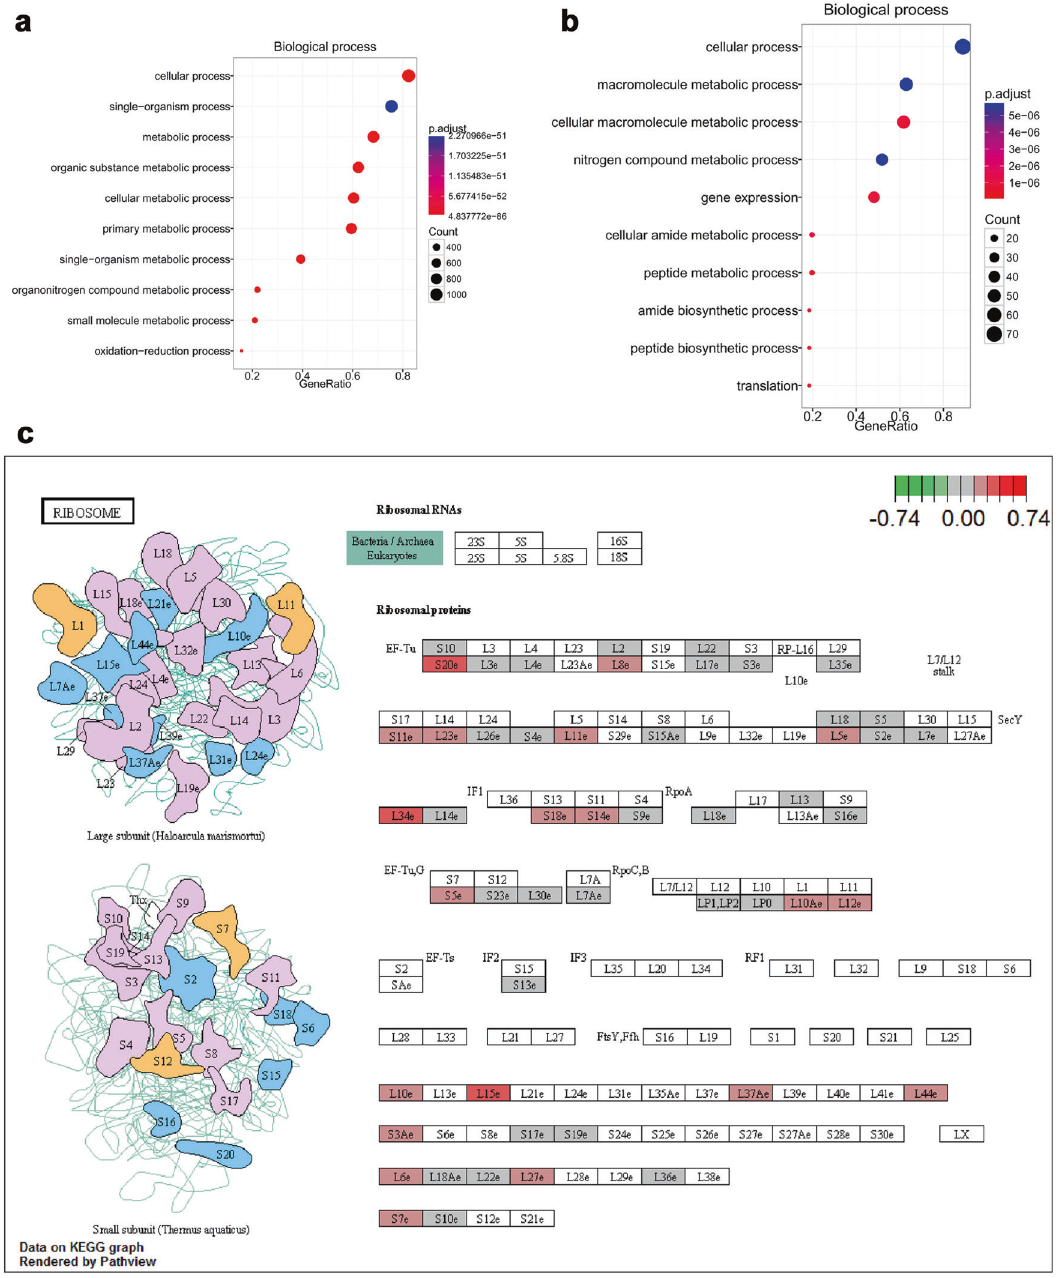
Fig. 7 Biological process of GO analysis and KEGG analysis. a , b Biological processes of total identi fi ed proteins and proteins upregulated upon H 2 O 2 treatment. c KEGG pathway map. KEGG analysis showed that the upregulated proteins were mainly involved in ribosome Rpl15 can promote metastatic growth in multiple organs 38,41 . The number of nucleoli and the expression of nucleolar proteins increased when Rpl15 was overexpressed, and abnormal increases in nucleolar size and number caused by dysregulation of ribosome biogenesis have emerged as hallmarks of the majority of spontaneous cancers 42 . Mechanistically, overexpression of Rpl15 selectively enhances translation of other ribosomal pro- teins 38 . Furthermore, Rpl15 siRNA-mediated downregulation induces cell cycle arrest by inhibiting cyclin-dependent kinases and results in a signi fi cant increase in the percentage of apoptosis in cancer cells 38,41 . Therefore, Rpl15 is the most critical ribosomal protein in carcinogenesis, increasing the risk of tumor formation in IVF-derived offspring.